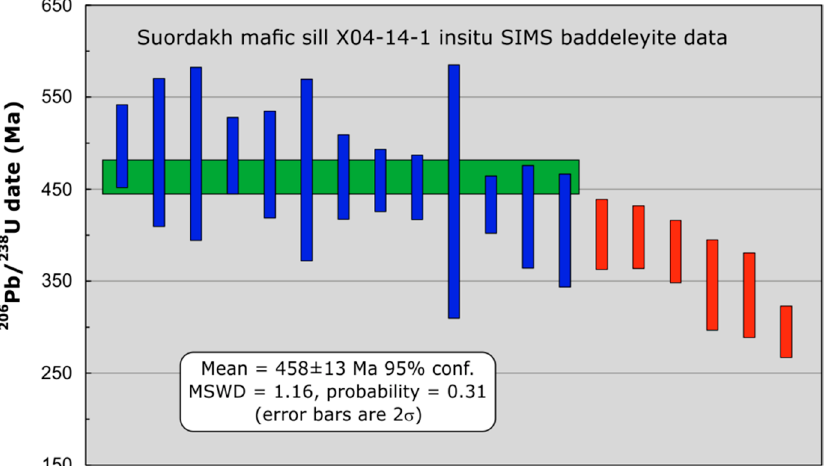
Figure 6. Plot of 206 Pb/ 238 U dates from in-situ SIMS analyses from X04-14-1. Blue bars overlap and produce a weighted mean date of 458 ± 13 Ma (green box), which was interpreted as the best estimate for intrusive age. Red bars were excluded from the calculation, as their dates were younger than this mean. They were interpreted to represent Pb loss and/or alteration.